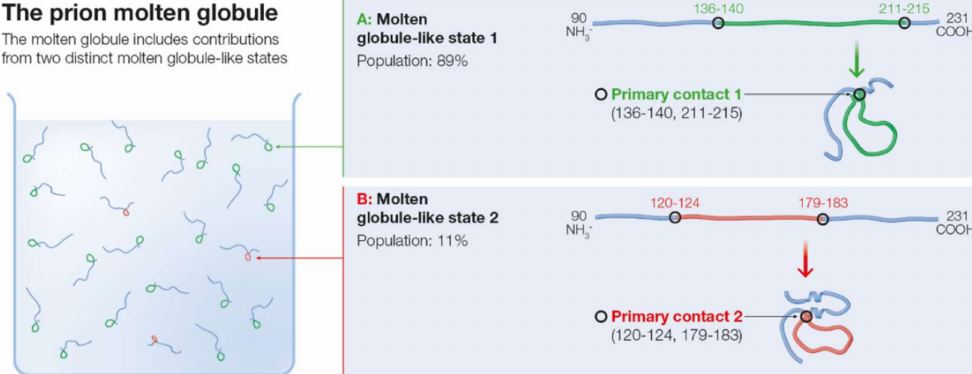
Figure 2. The molten globule of m PrP(90–231) includes contributions from two distinct MGLISs arising from the two primary contacts: ( A ) the MGLIS arising from the dominant primary contact, including helix 3; ( B ) the MGLIS arising from the second-best primary contact including helix 2 and, possibly, also helix